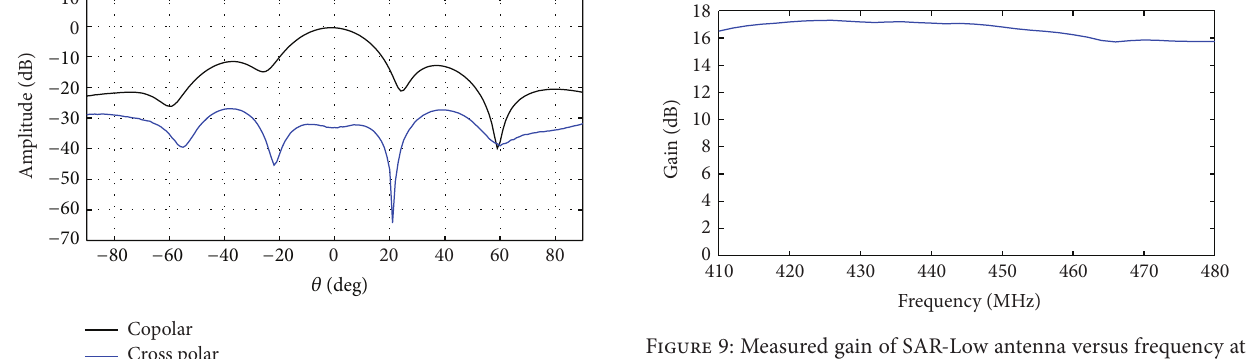
Figure 9: Measured gain of SAR-Low antenna versus frequency at boresight.